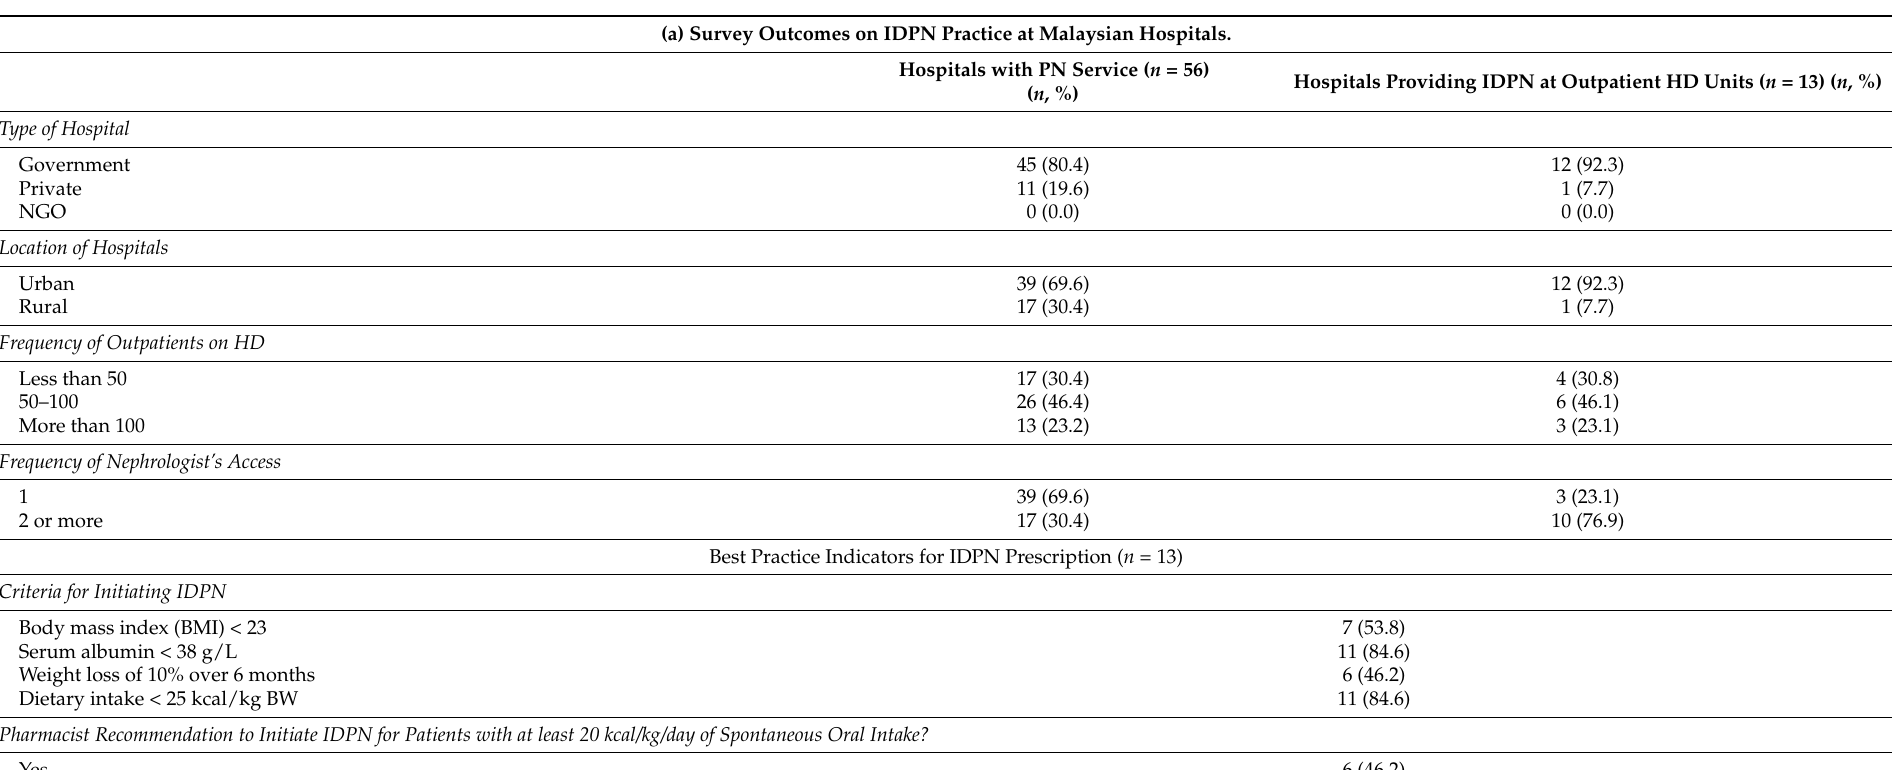
Table 2. Survey Outcomes on IDPN Practice at Malaysian Hospitals and Factors Affecting IDPN Practice at Outpatients’ HD units. (a) Survey Outcomes on IDPN Practice at Malaysian